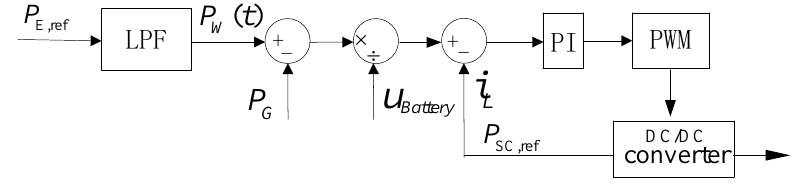
Figure 9. Control of the interface circuit of battery.